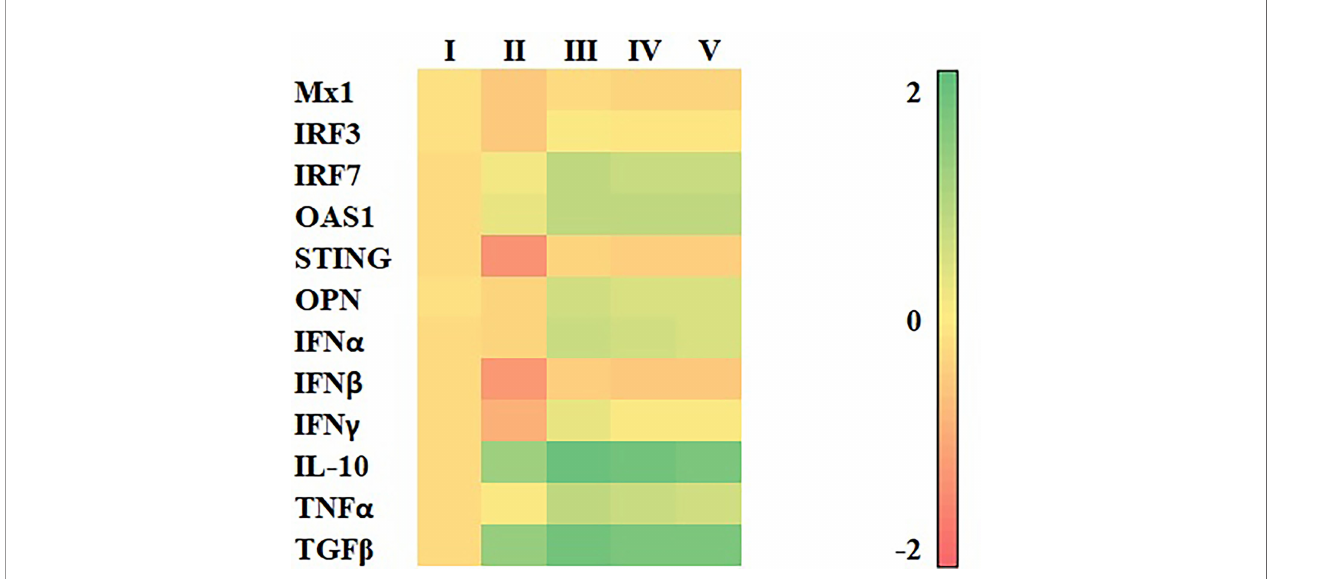
FIGURE 5 | Heat map illustrating levels of immune-related gene expressions of MDMs ( n = 4 pigs) inoculated with HP-PRRSV-2 and treated with either HC50, HC70, or HC95 (0.8 mg/ml fi nal) as determined by real-time PCR. MDMs were inoculated with HP-PRRSV-2 for 48 h, then received either HC50, HC70, HC95, or RPMI ++ for 12 h. Controls were MDMs incubated with mock Ags and received either vehicle solution (vehicle control) or RPMI ++ (mock control). Levels of mRNA expressions of immune-related genes were normalized to geometric average of RPL32 and YWHAZ of the same pigs. Expressions of immune-related genes in all groups were transformed to log2 scale and were presented in fold change, according to the 2 − DD CT method, relative to those in mock control. I = Vehicle control; II = HP-PRRSV-2-inoculated MDMs; III = HP-PRRSV-2-inoculated/HC50-treated MDMs; IV = HP-PRRSV-2-inoculated/HC70-treated MDMs; and V = HP-PRRSV-2- inoculated/HC95-treated MDMs.